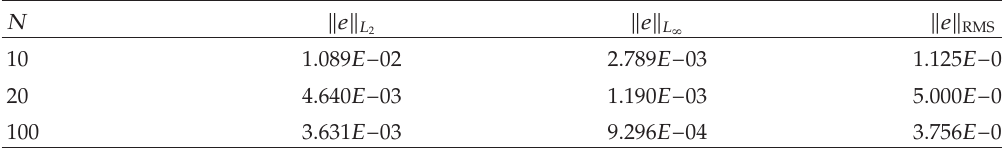
Table 2: Error norms for ν (cid:8) 1 at T (cid:8) 0 . 1 with di ff erent step